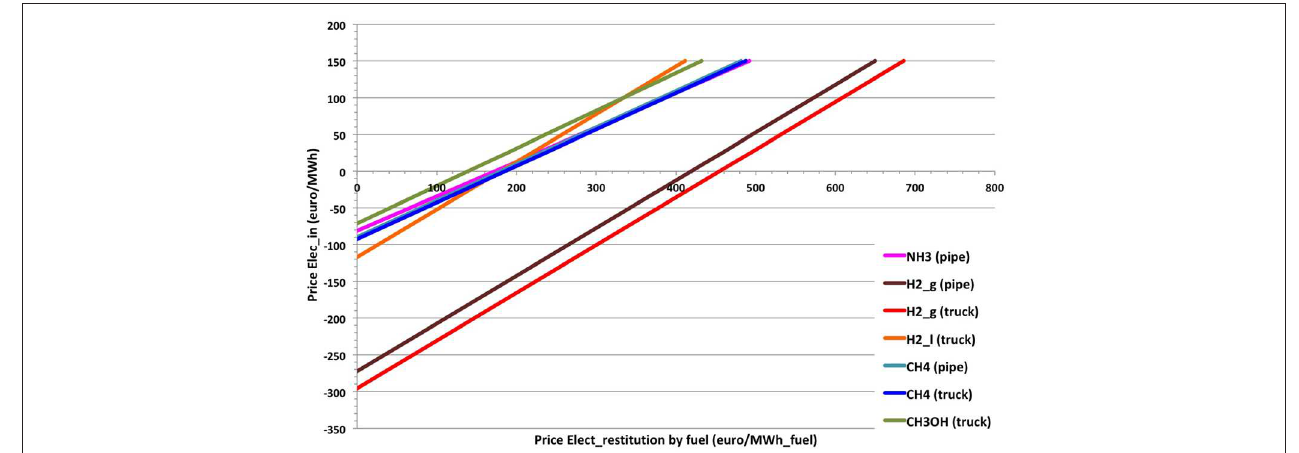
FIGURE 8 | Price of electricity restored by fuel, according to the initial electricity price injected in the global